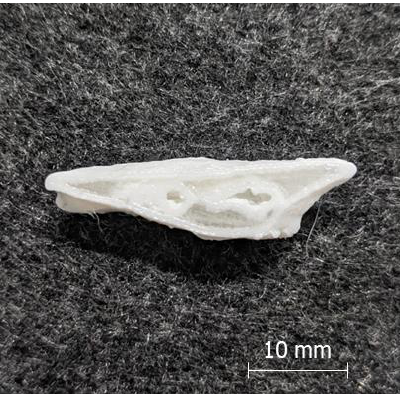
Figure 4. Results of the dual print: picture A shows the outside of implant B, picture B the inside; picture C [7] shows the outside of implant A, picture D [7] the inside (with porous inner bone structure).